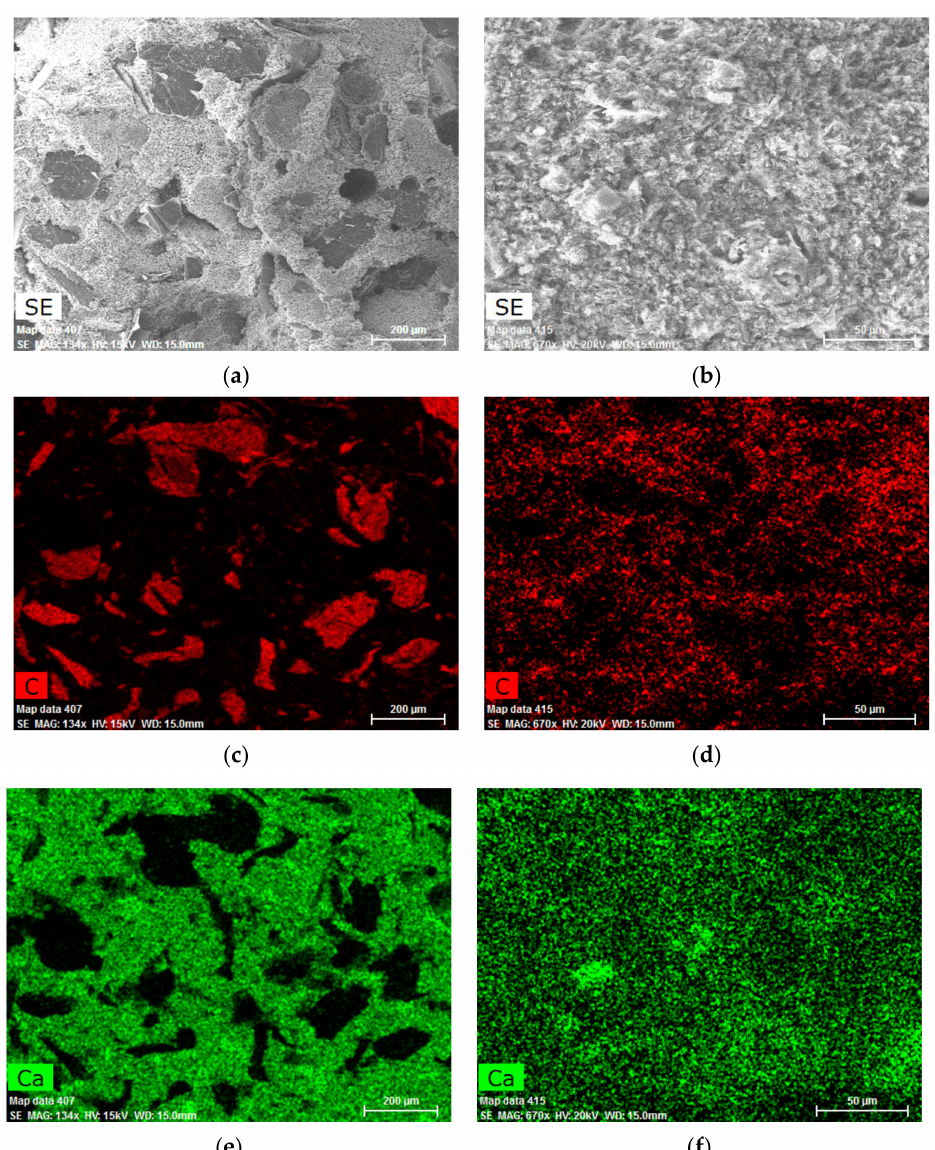
Figure 18. Images from the scanning electron microscope using the EDX analysis of cement pastes with graphite fillers: ( a ) SEM of the surface of a specimen with the Supragraphite C300 filler upon magnification 134 × ; ( b ) SEM of the surface of a specimen with the Condufit C4 filler upon 670 × mag- nification; ( c ) the red presence of carbon in a specimen with the Supragraphite C300 filler upon 134 × magnification; ( d ) the red presence of carbon in the sample with the Condufit C4 filler upon 670 × magnification; ( e ) the green presence of carbon in a specimen with the Supragraphite C300 filler at 134 × magnification; ( f ) the green presence of carbon in a specimen with the Condufit C4 filler upon 670 ×